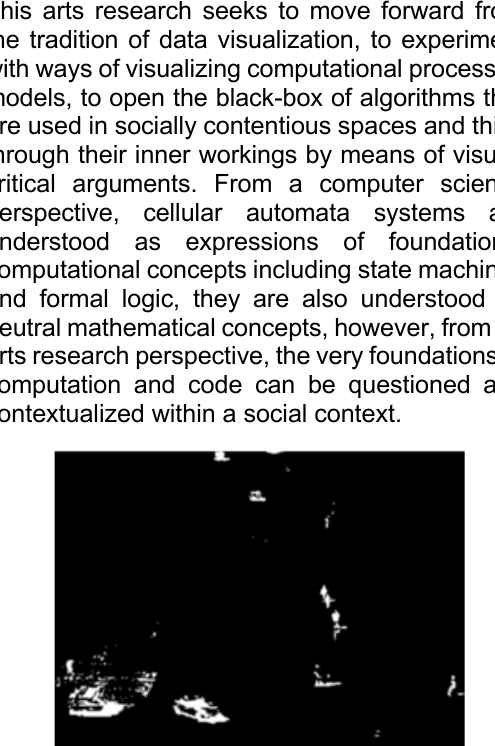
Figure 5 | Langton’s ant